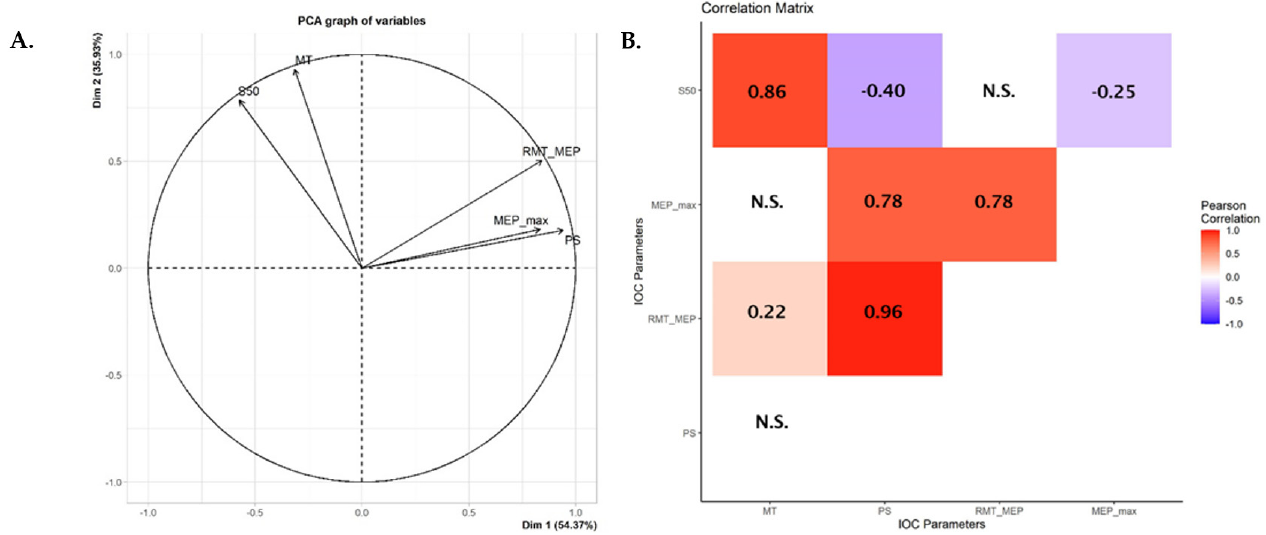
Figure 3. Correlation between the different IOC parameters. ( A ) PCA correlation circle where the x and y axis represent the first two principal components obtained from PCA. Parameters with arrows in same direction are strongly correlated while orthogonal parameters are not correlated. ( B ) A Pearson’s correlation matrix for the significant parameters is shown. (N.S. = non-significant correlation, p > 0.05).